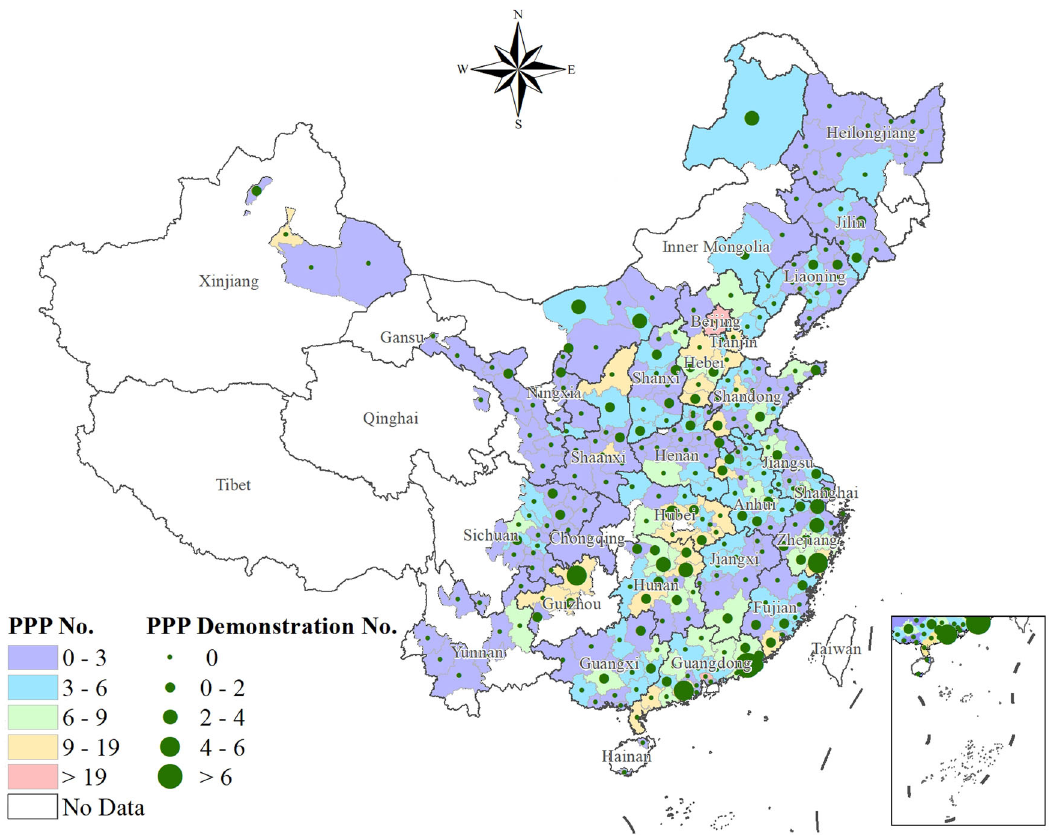
Fig. 1 PPPs for wastewater treatment in Chinese prefecture-level cities. The data of the PPP projects at the end of 2019 is shown. PPP No. represents the number of PPP projects for wastewater treatment, and the colour from purple to red represents the number of projects from small to large. The critical value takes the colour which belongs to the higher interval. PPP Demonstration No. represents the number of PPP demonstration projects for wastewater treatment, and the green dots from small to large represent the number of demonstration projects from small to large. The critical value takes the dot scale which belongs to the higher interval. The division of the research area is based on prefecture-level cities. The uncoloured prefecture-level cities lack data on PPP